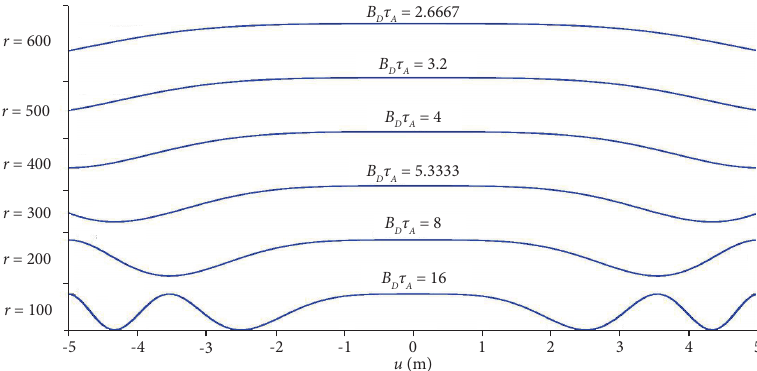
Figure 8. Azimuthal phase histories cos2 Dƒ